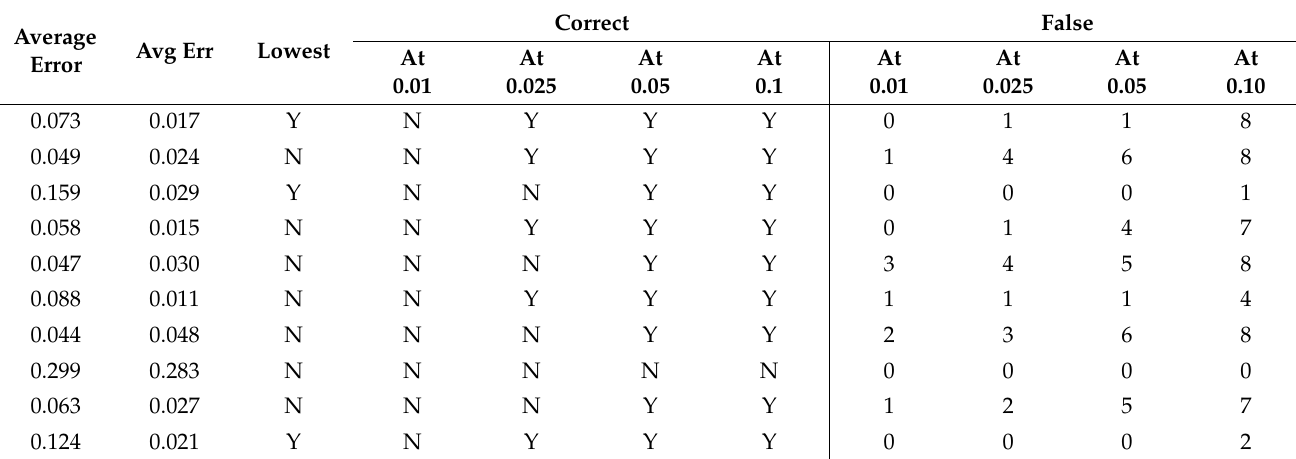
Table A122. Set 2, trials 21–30 summary data (single 0.5 PR